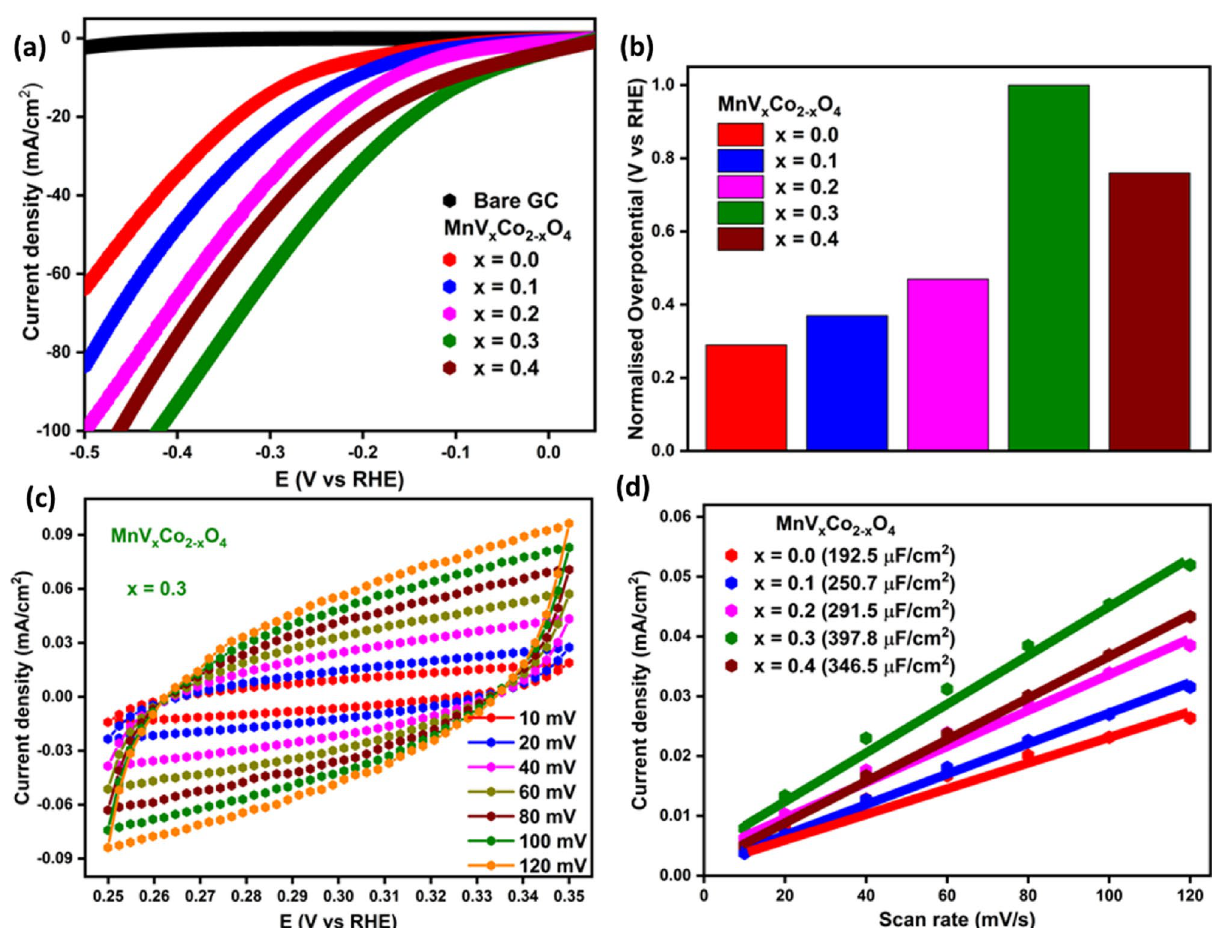
Figure 10. (a) LSV curves of V x -MnCo (x ≤ 0.4) MCs; (b) comparison plot between different catalysts of V x -MnCo MCs and their respective normalized overpotentials at the current density of 10 mA/cm 2 ; (c) CV curves recorded in non-Ohmic region of −0.25 to −0.35 V versus RHE at different scan rates for V x -MnCo MCs (x = 0.3); (d) current density versus scan rate plot to estimate the value of C dl for all the prepared